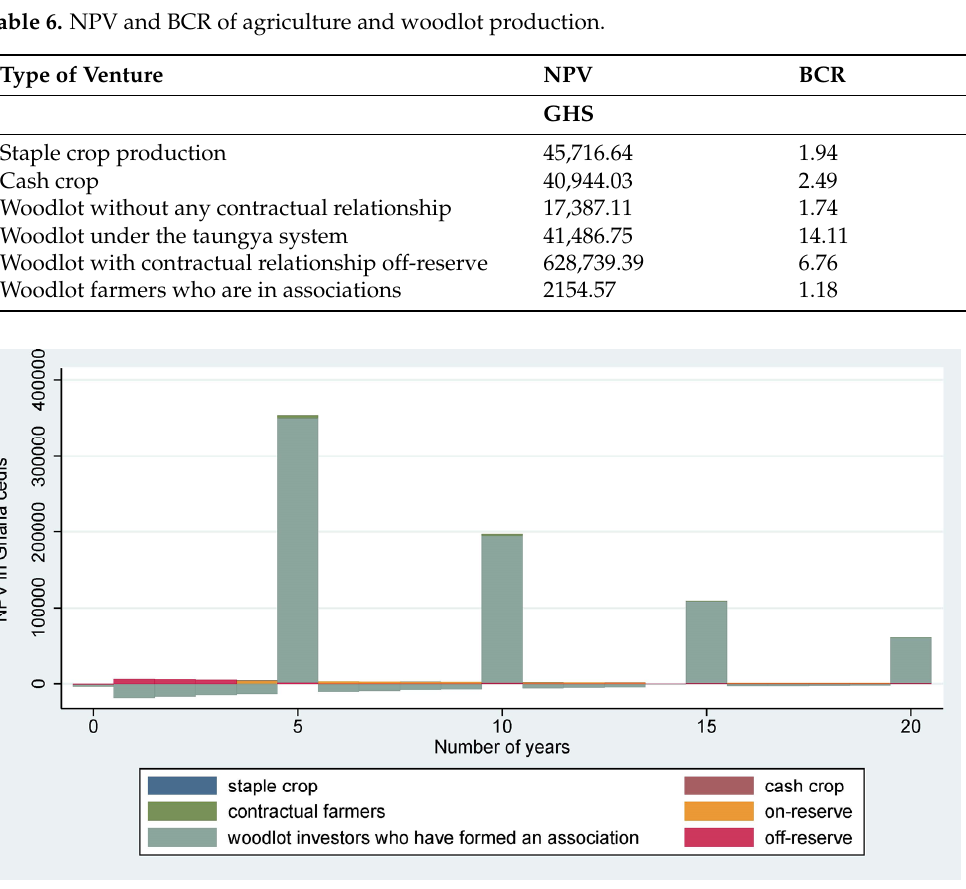
Figure 2. NPV of various